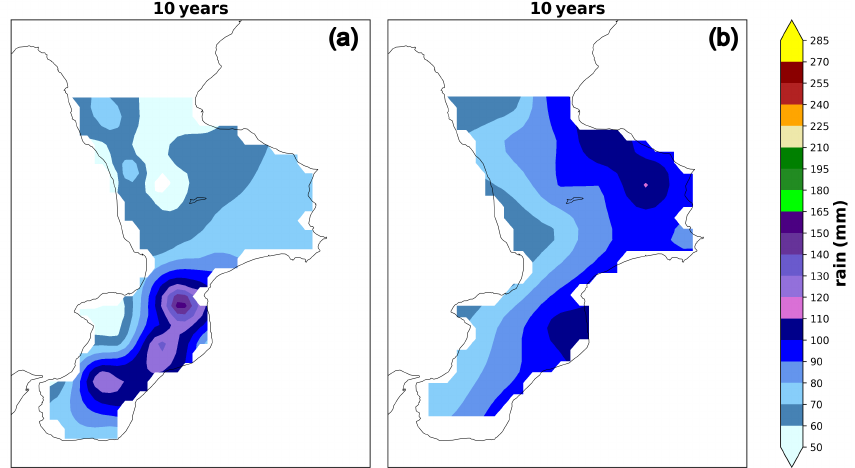
Figure 7. Comparison between the daily rainfall return-level maps for return period of 10 years. Return-level maps for the observed data ( a ) and for the ERA5 data ( b